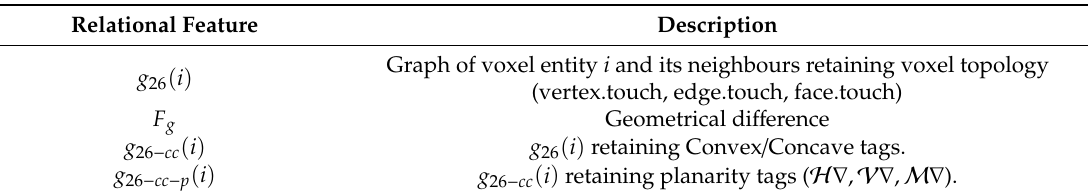
Table 3. Relational features of the SF2 feature set for three-dimensional (3D) structural